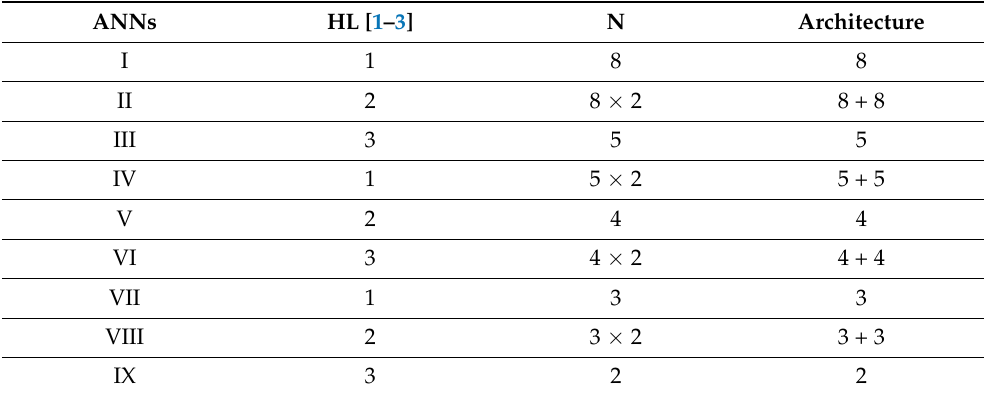
Table 2. Nine different architectures of ANN (from I to IX) defined by a specific combination of Hidden Layers (HL) and number of Neurons (N). ANNs HL [1–3] N